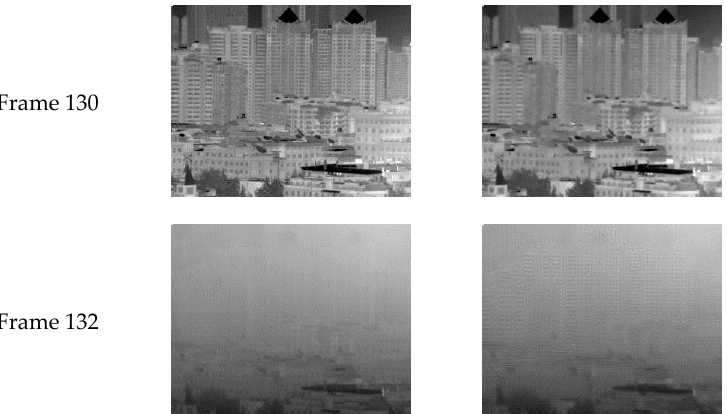
Figure 1. An example infrared sequence processed by Scribner’s method. The first column is the original image, the second column is the processed image.